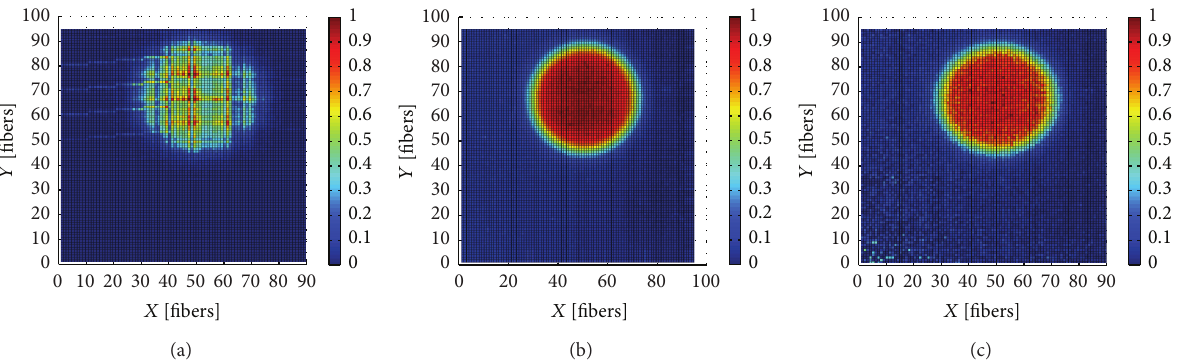
Figure 21: (a) The gafchromic EBT film image, (b) the raw sum of all the images with OFFSET, and (c) the corresponding image, calibrated. Axes are in fiber units (500 𝜇 m).